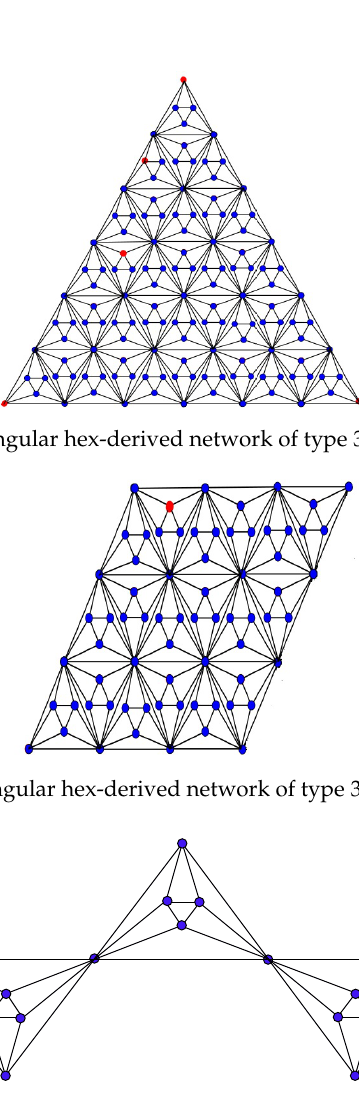
Figure 5. Chain hex-derived network of type 3 ( CHDN 3 ( 5 )